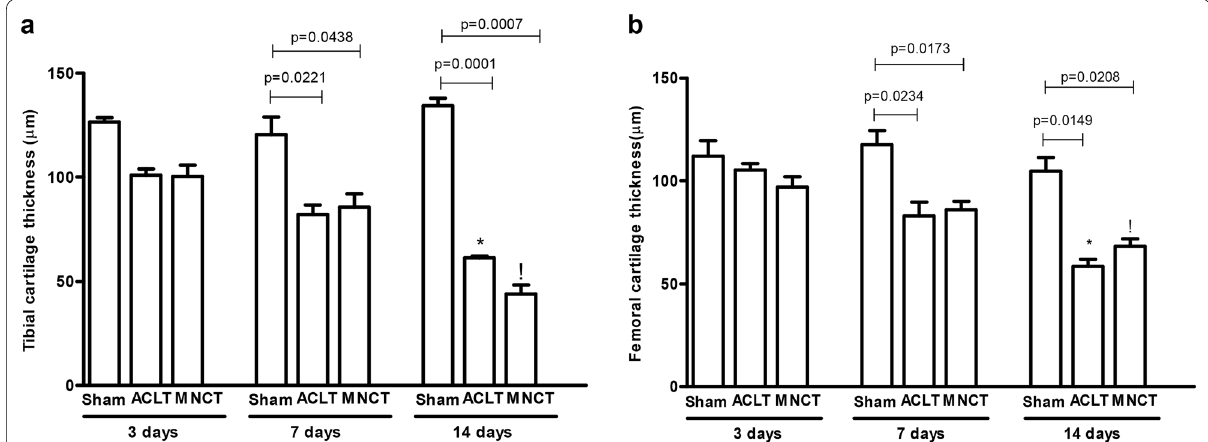
Fig. 1 Assessment of femoral ( a ) and tibial ( b ) cartilage thickness. Mice were subjected to a sham procedure or transection of the medial collateral and anterior cruciate ligaments (ACLT) or ACLT followed by transection of the medial meniscus (MNCT). Groups were sacrificed 3, 7 or 14 days post surgery. Data represent mean sem of cartilage thickness (µm) using scanning electron microscope (SEM) images (9/group), compared using ± Student’s “t”